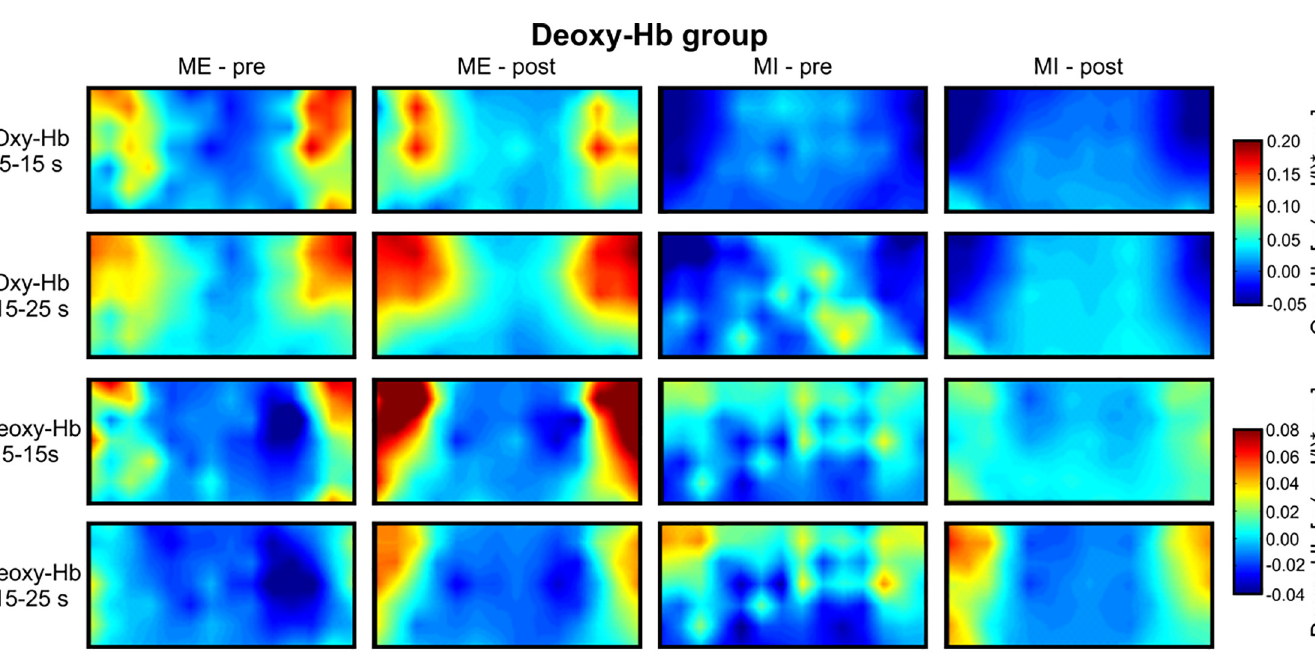
Fig 5. Topographical maps of deoxy-Hb. Grand average topographical maps of oxy- and deoxy-Hb during motor execution (ME) and motor imagery (MI) for the deoxy-Hb group, presented separately for the task interval (second 5 – 15 after task onset) and the pause interval (second 15 – 25 after task onset) and for the pre- and post-test. In the upper left map, the 48 NIRS channel locations are additionally marked.